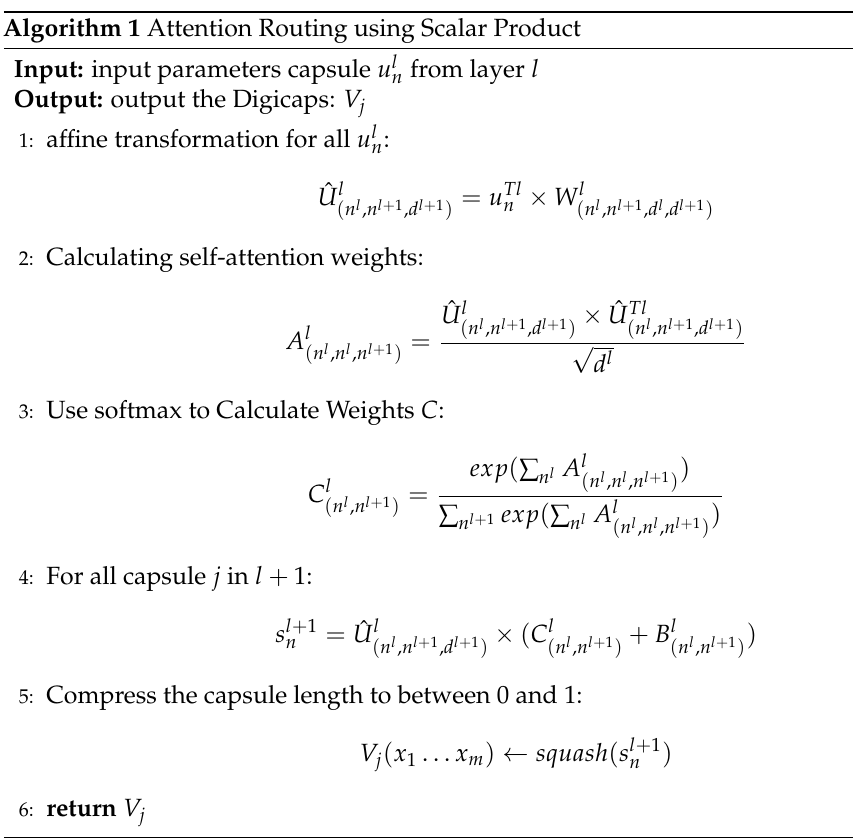
Algorithm 1 Explain how the data stream flows in digicaps. W l